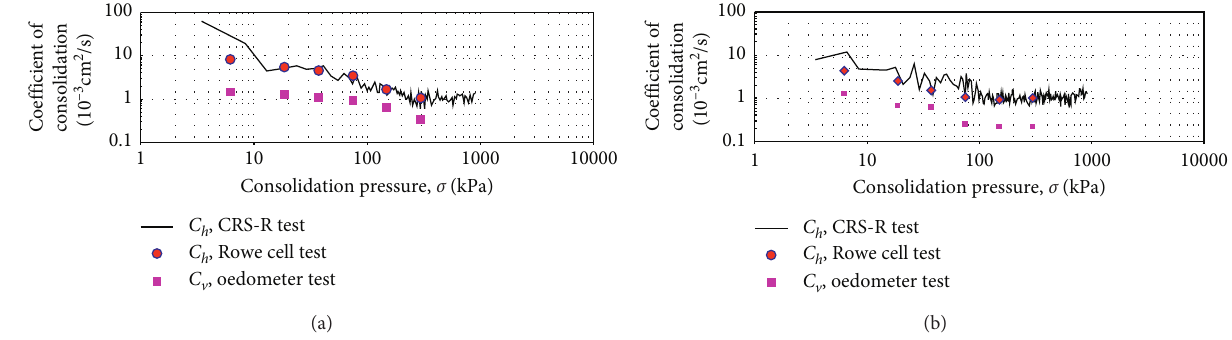
Figure 3: (a) The coefficient of consolidation of soft clay in Ca Mau province (Site 6). (b) The coefficient of consolidation of soft sandy clay in Ha Tinh province (Site 1).